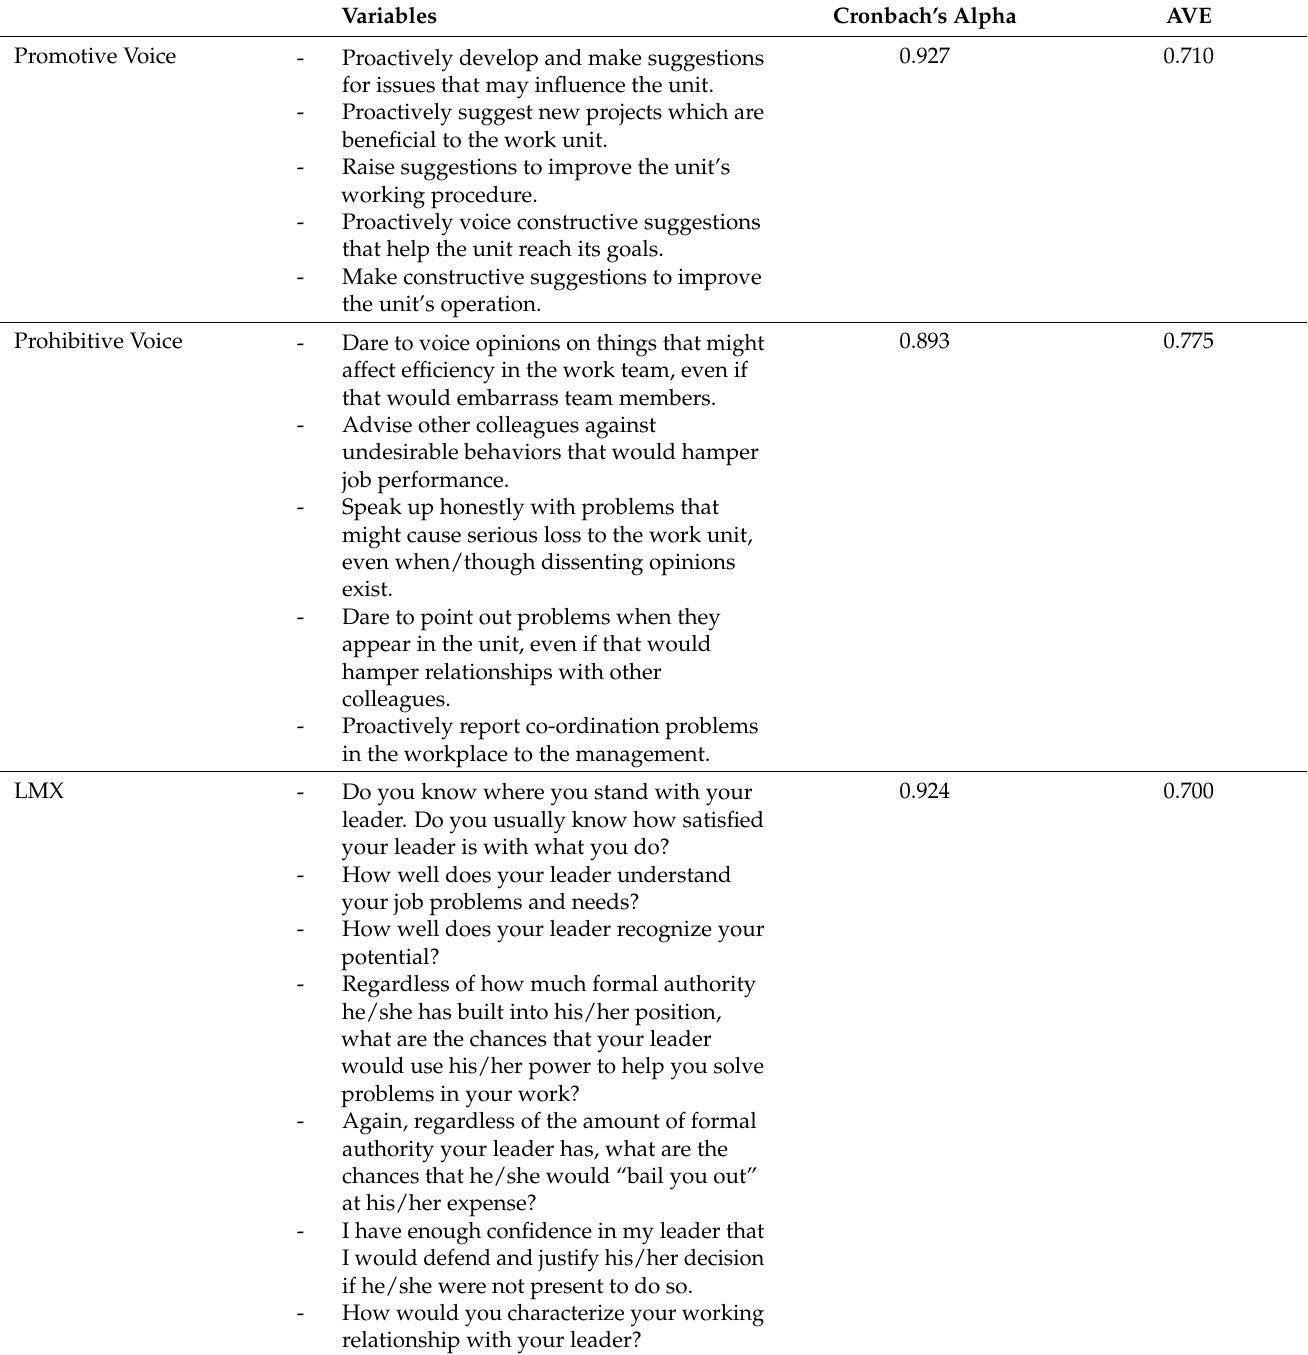
Table 2. Reliability and Validity Analysis of Study